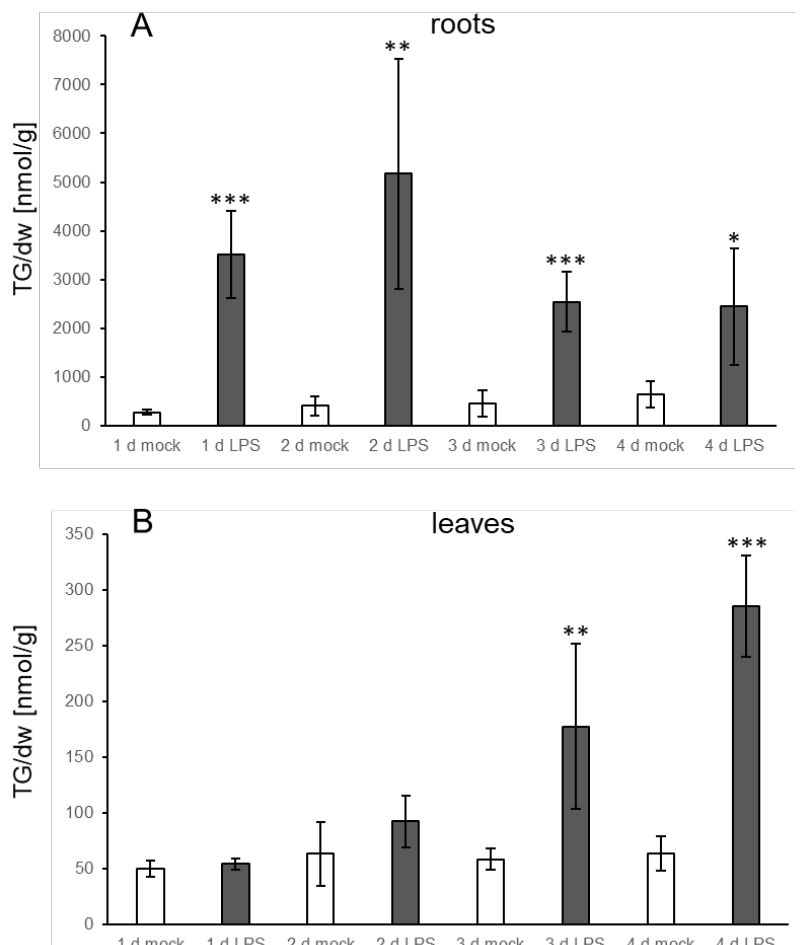
Figure 5. Accumulation of TGs in ( A ) roots and ( B ) leaves of Col-0 in response to treatment of roots with 50 µg/mL LPS (dark grey bars) or mock (white bars) at different time points. Shown is the mean of five biological replicates ± sd of the sum of TGs [nmol/g dry weight] with 52 and 54 acyl carbon atoms and one to nine double bonds. Asterisks indicate significant differences between the LPS treated samples and the corresponding mock treated sample (* p < 0.05; ** p < 0.01; *** p < 0.001).